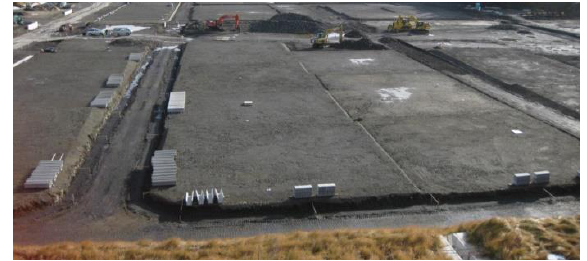
Figure 8. Work area with visible puddles